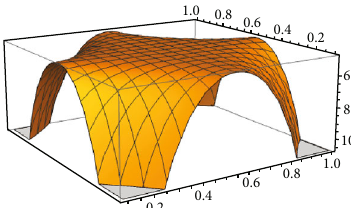
Figure 4: The Dirichlet integrand function for the biquadratic Bézier surface with shifted knots for η = 0 : 2 and λ = 0 : 2